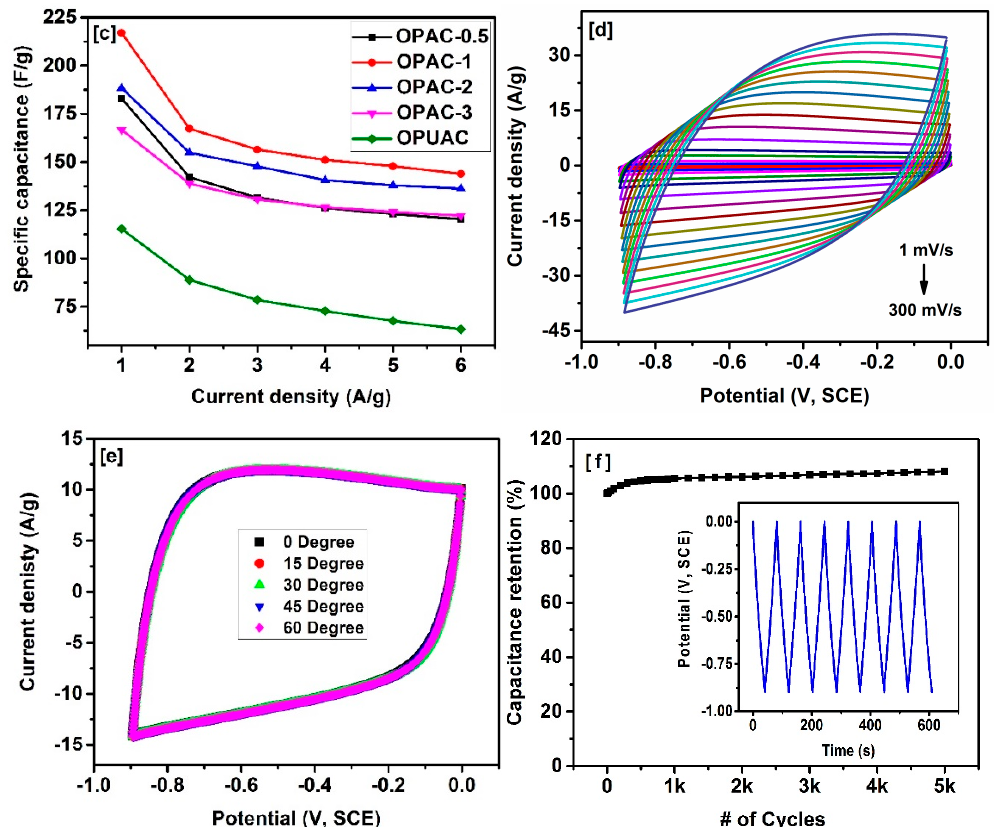
Figure 4. ( a ) CV curves at the scan rate of 10 mV/s; ( b ) GCD profiles at the current density of 1 A/g; ( c ) specific capacitances at different current densities; ( d ) CV curves of OPAC-1 at various scan rates. ( e ) CV curves of OPAC-1 for various bending angles at the scan rate of 100 mV/s; and ( f ) cyclic stability of OPAC-1 at current density of 2 A/g for 5000 cycles; inset shows GCD profiles of the first and last few cycles.